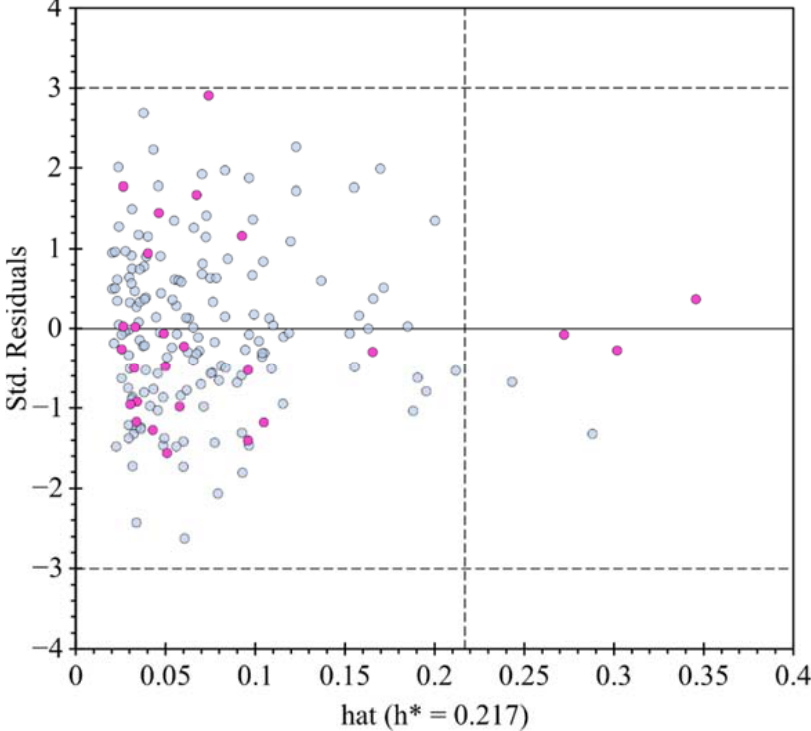
Figure 6. William’s plot with an up and low limit of 3 σ and − 3 σ respectively, for the training set (light blue dots) and for the test set (violet dots).